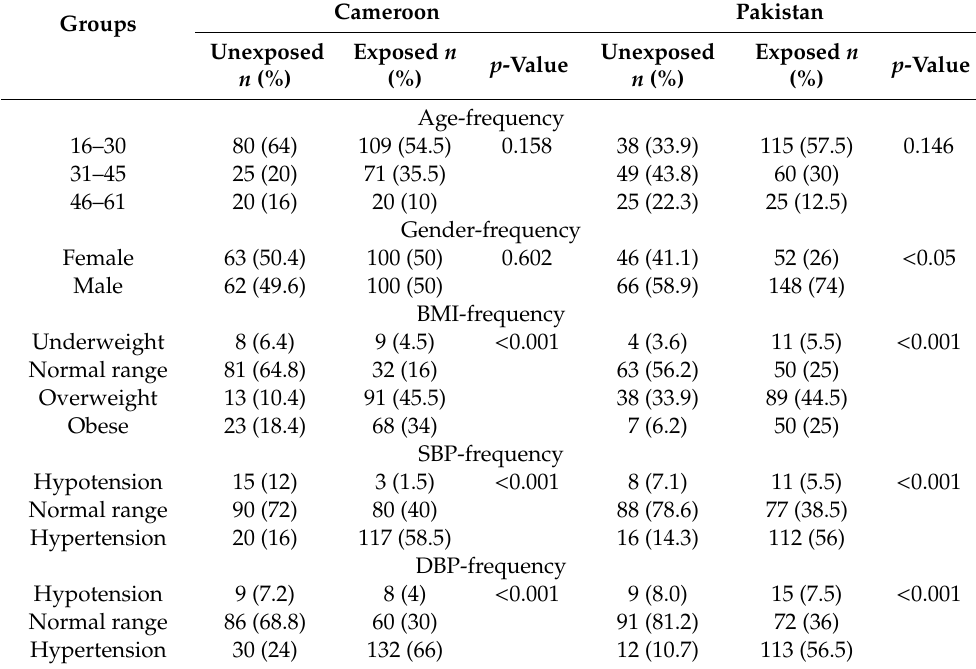
Table 1. Sociodemographic characteristics of study participants.